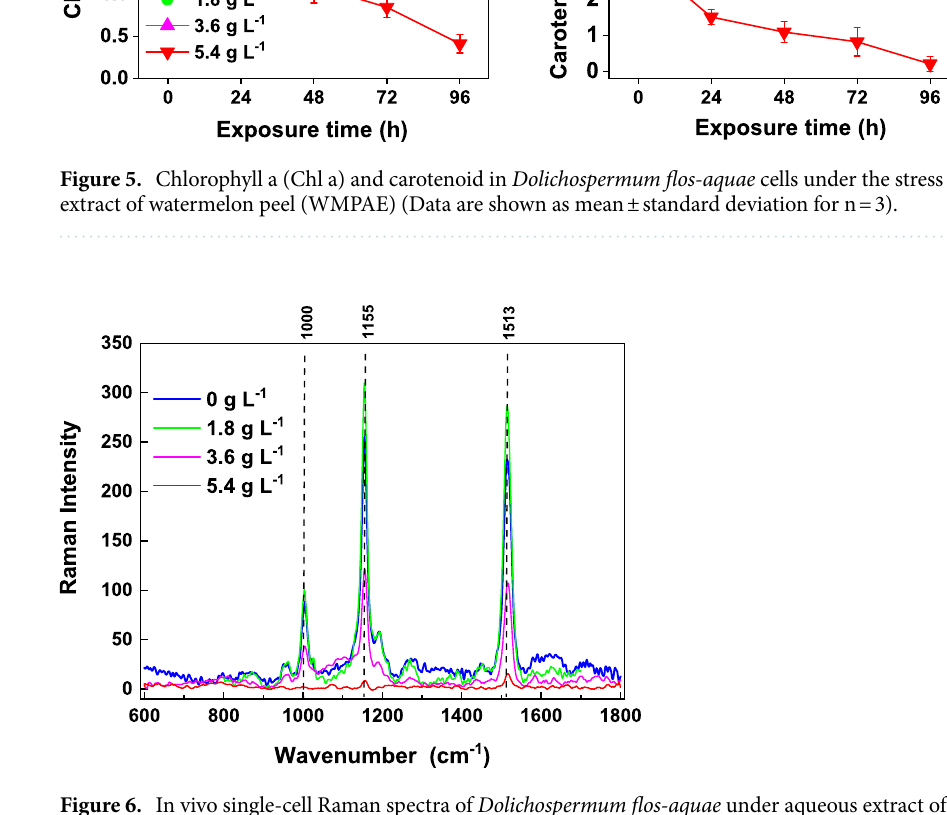
Figure 6. In vivo single-cell Raman spectra of Dolichospermum flos-aquae under aqueous extract of watermelon peel (WMPAE)